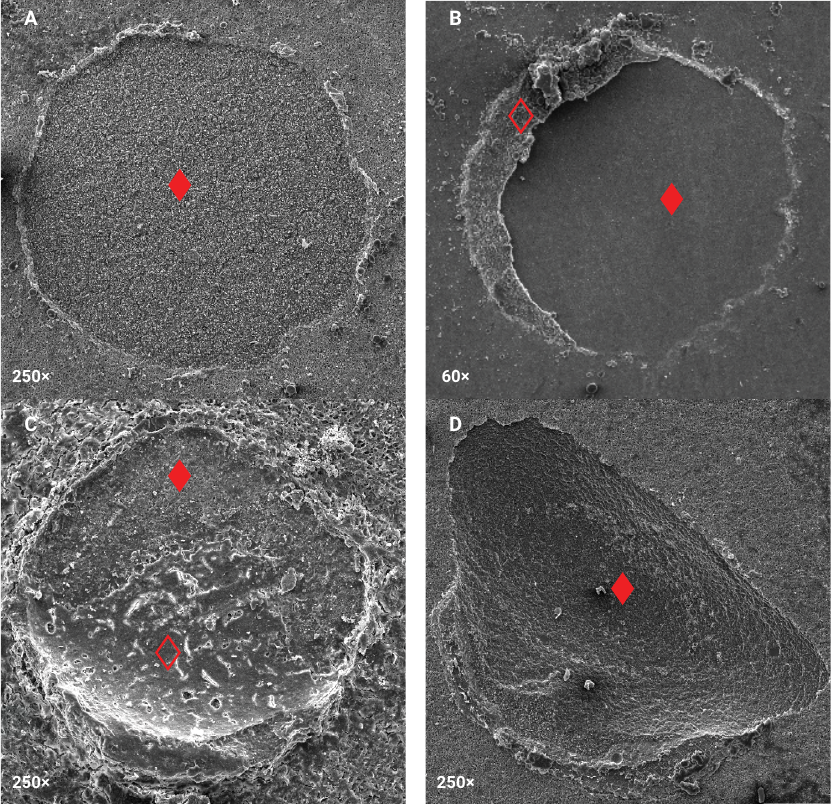
Figure 2. Representative micrographs (SEM images; 60-250× magnification) of the failure modes after the microshear test. A depicts the adhesive failure mode at the ceramic/cement interface; B demonstrates the predominantly adhesive failure mode; C exhibit a cohesive failure in cement and D shows a cohesive failure in ceramic. The symbol ( ♦ ) represents the ceramic surface free of cement, while the symbol (◊) represents the surface with the presence of resin